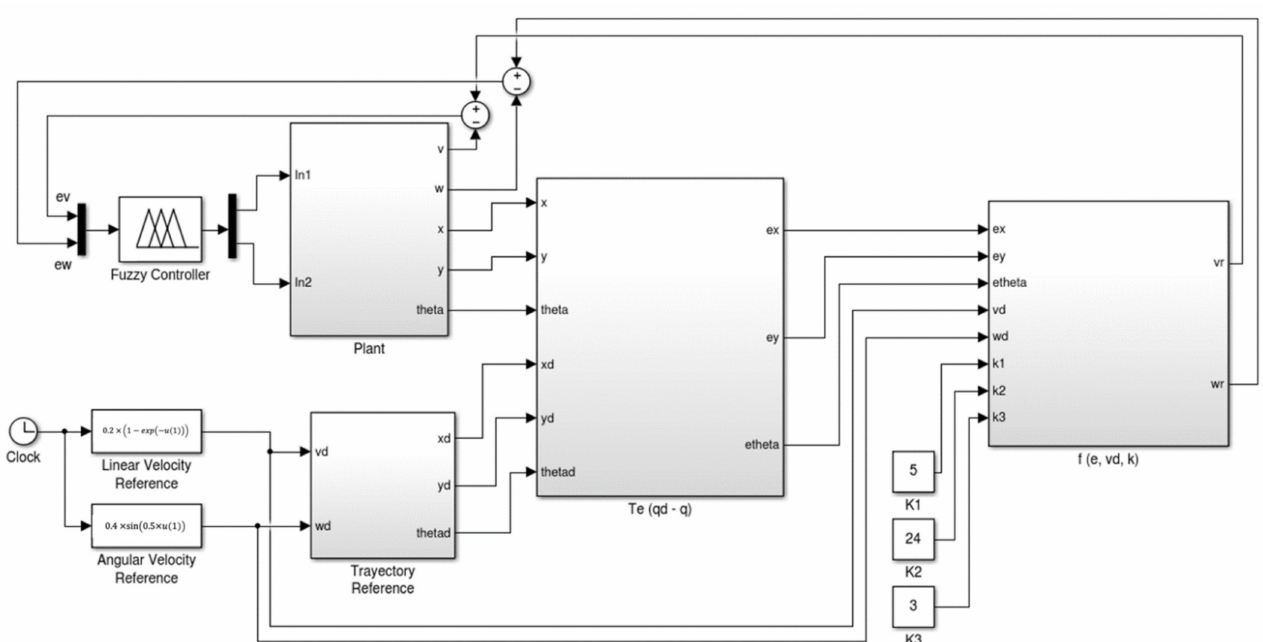
Figure 16. Representation in the model for the control problem.